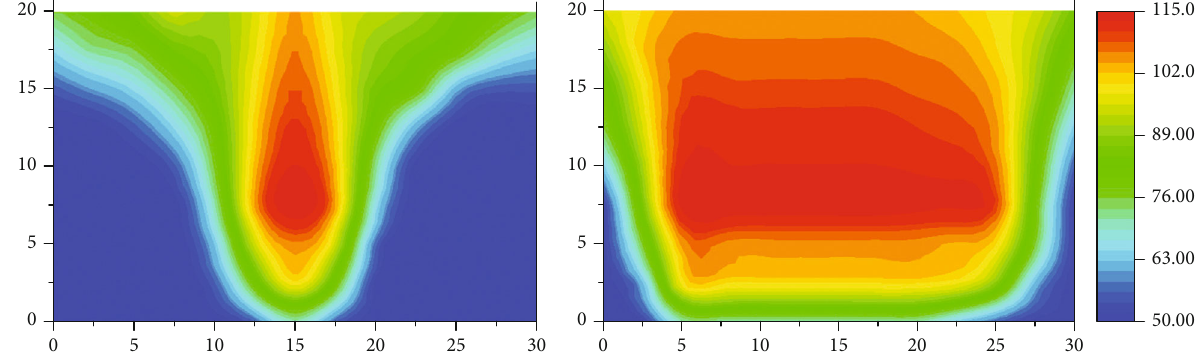
Figure 10: Temperature fi eld in the 3D model during the middle stage of Experiment 2: (a) in the vertical direction of the wells and (b) along the wells.